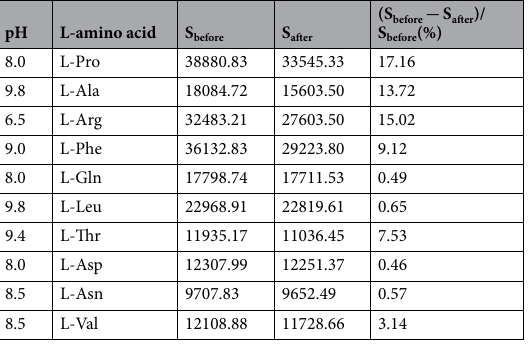
Table 5. Quantification of L-amino acids before and after reaction of DAAO by CE